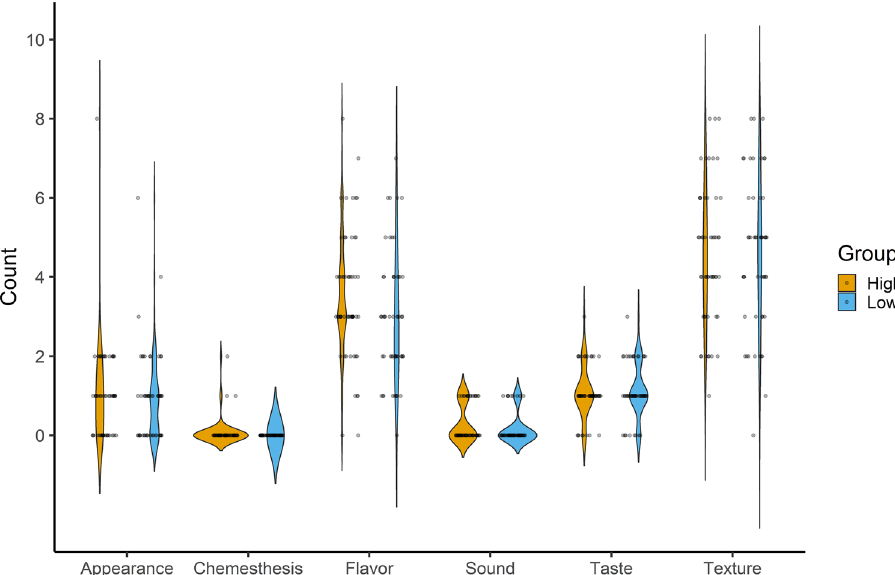
Figure 3. Violin plot with usage frequency of different term types among high and low touch sensitivity groups. No differences were seen across the sensitivity groups. Texture terms were chosen the most followed by flavor and taste/appearance. Terms include those presented in the CATA term bank as well as those defined by the individual.